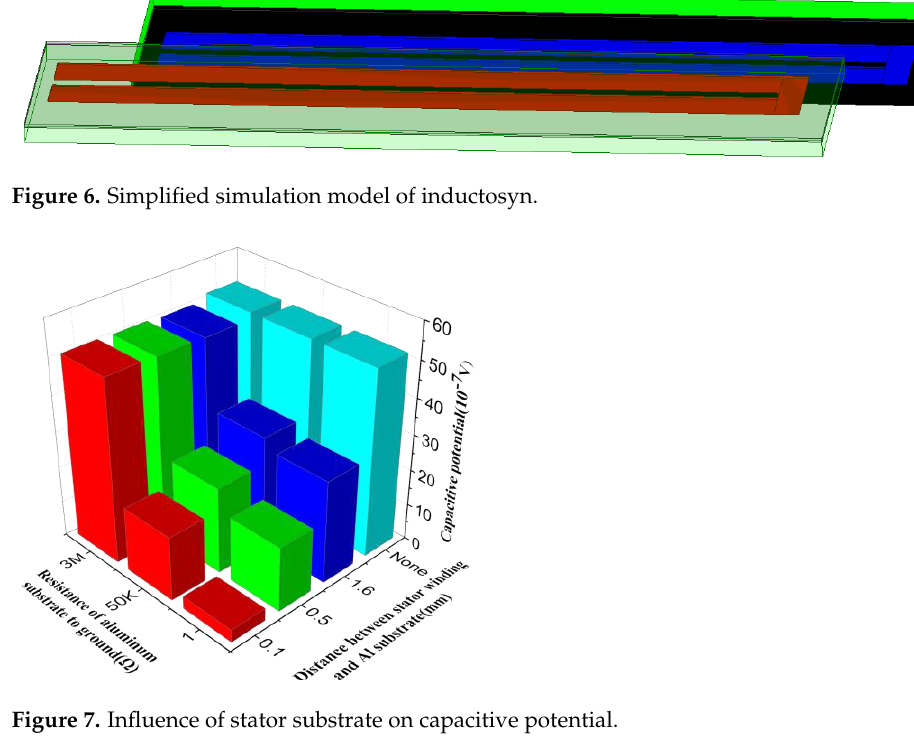
Figure 8. Capacitance network model with shielding film.